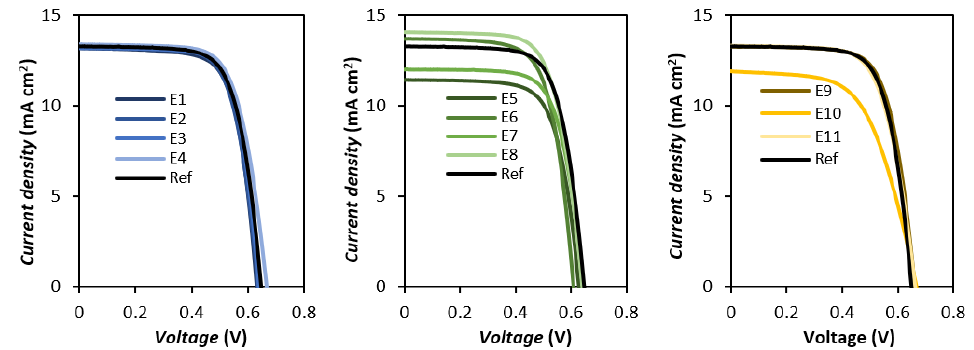
Figure 4. J - V curves of the test cells employing the various iodide-based organic salts and 0.5 M 4-TBP as additives, under 100 mW cm − 2 simulated AM 1.5G illumination. The above results correspond to the best performing cell.